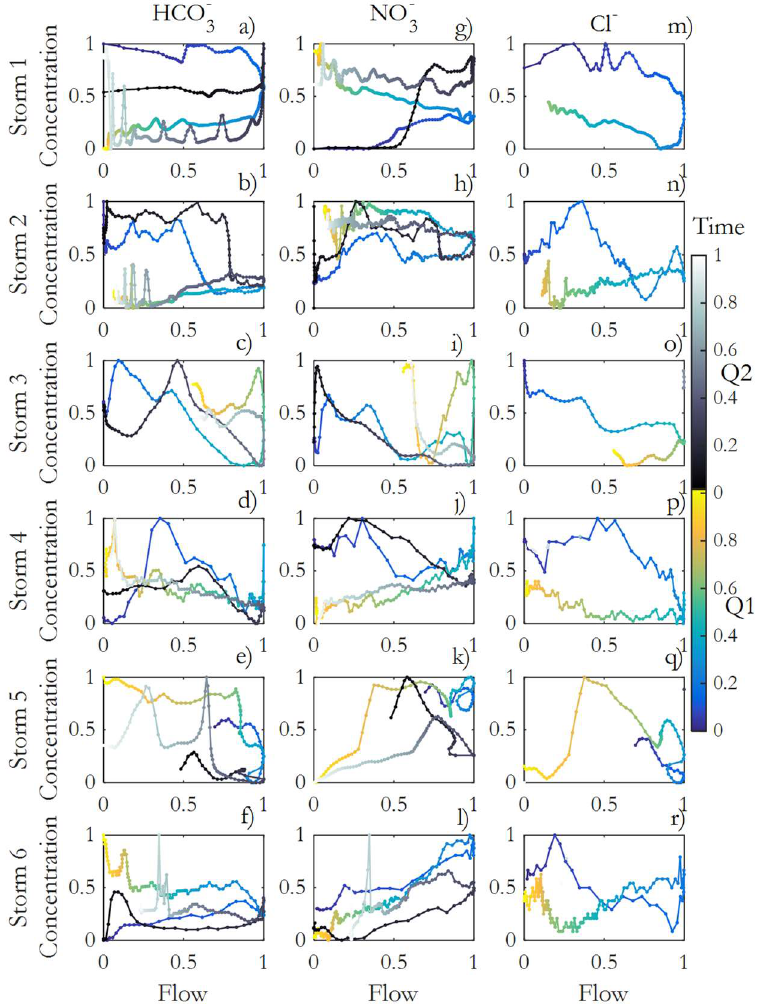
Figure 5. Hysteresis of six rainstorms using HCO 3 − ( a – f ), NO 3 − ( g – l ) and Cl − ( m – r ) in Q1 and Q2 locations along the Kanawha River. The transient response advances in Q1 and Q2 from 0 to 1 for any rainstorm.